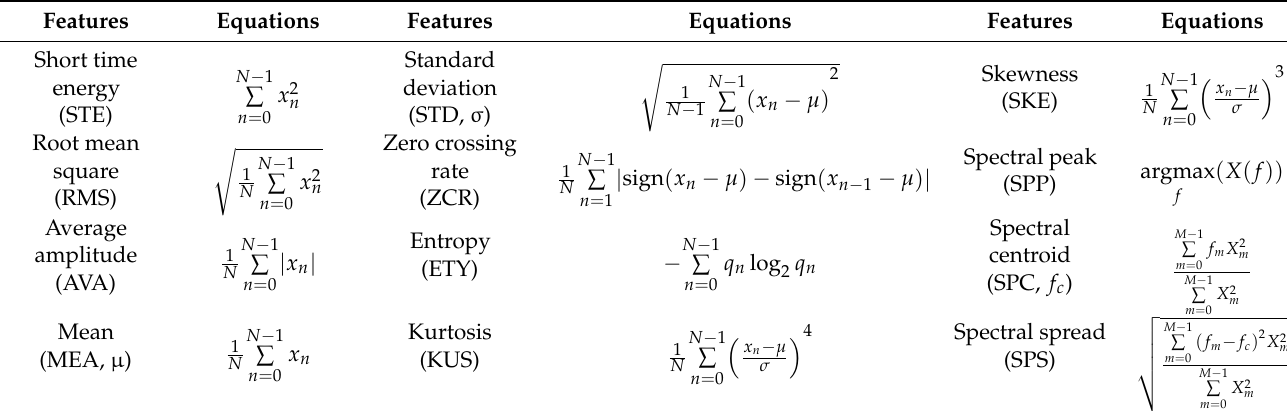
Table 1. Typical features for leak detection.